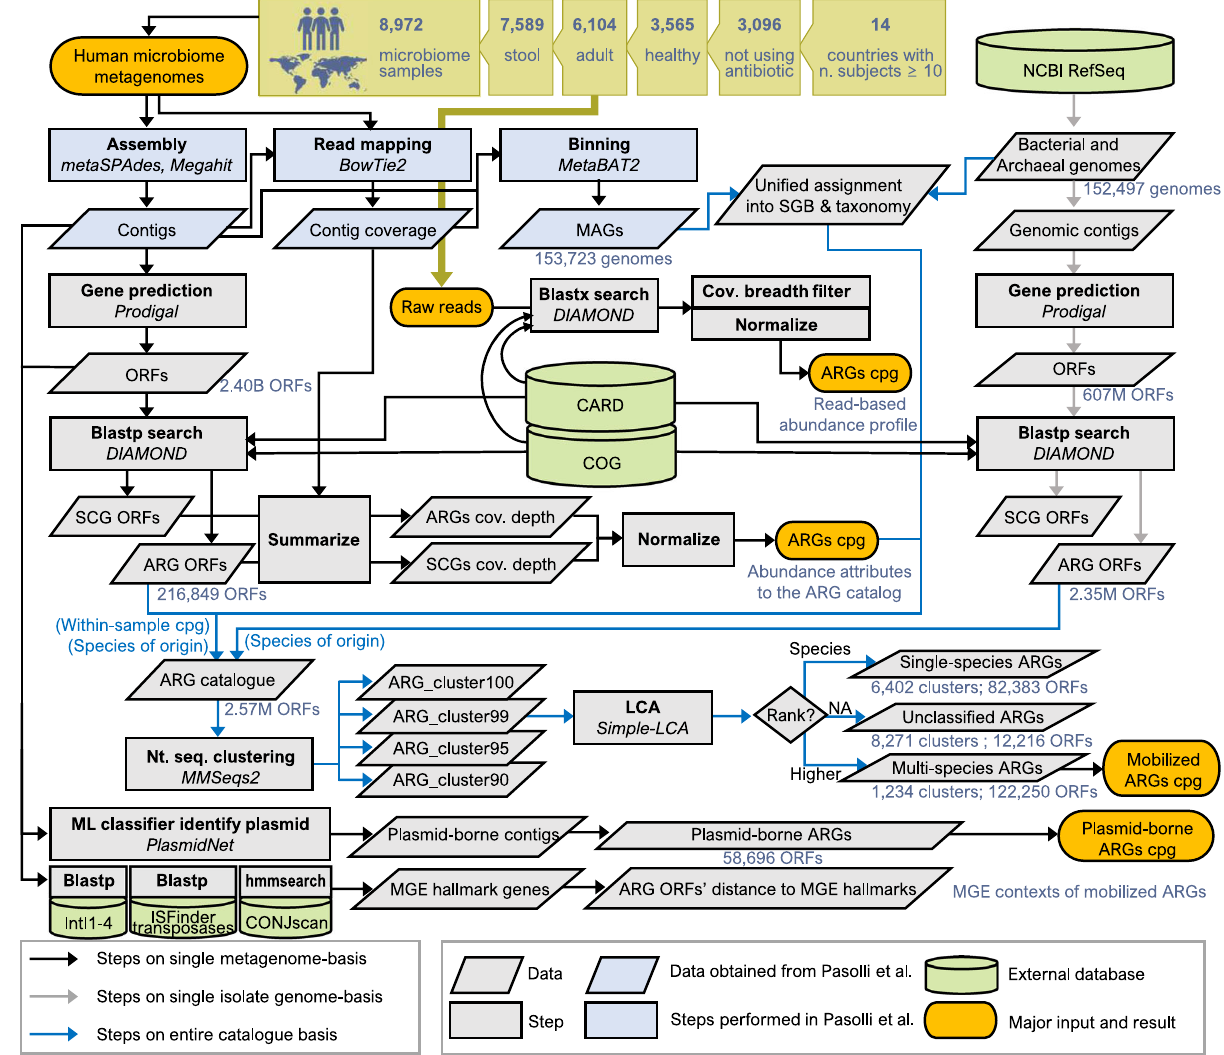
Fig. 1 | A schematic overview of the bioinformatics pipeline employed in the study. Thissummarisestheoverallstrategyusedtopro fi leARGsinthemicrobiome samples and compare to the genome collection, for details see the Methods. The